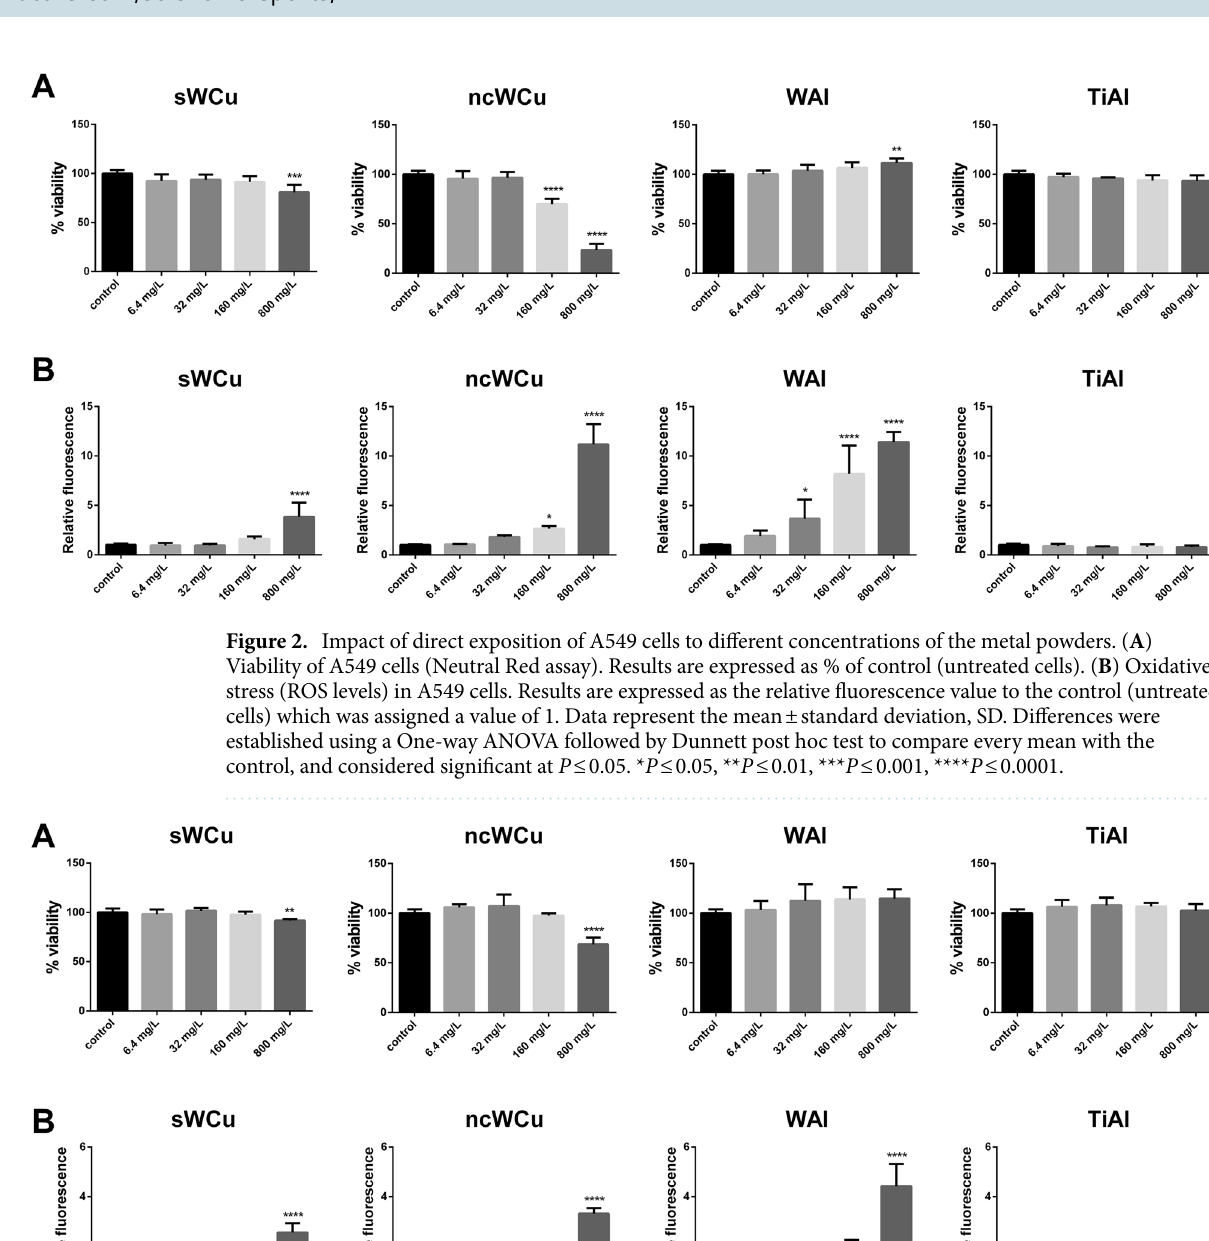
that critically affect the inherent toxicity of an alloy. For instance, in the case of Ti, experimental results showed that the elemental powder of this metal can be substantially cytotoxic, while bulk Ti is biocompatible 23 . The authors explained the observed differences arguing that the concentration of ions released into the media by bulk elemental metals is significantly lower than that released by powder, thus being less cytotoxic. In the present work, the selected alloys subjected to study were in powder form, presenting particles in the micrometre scale. Considering their ability to reduce cell viability and cause oxidative stress, the results showed that ncWCu is the most cytotoxic alloy, while TiAl is the safest one in the studied conditions. The obtained results also indicated a correspondence between the susceptibility of the materials to leach and their associated toxicity: ncWCu was